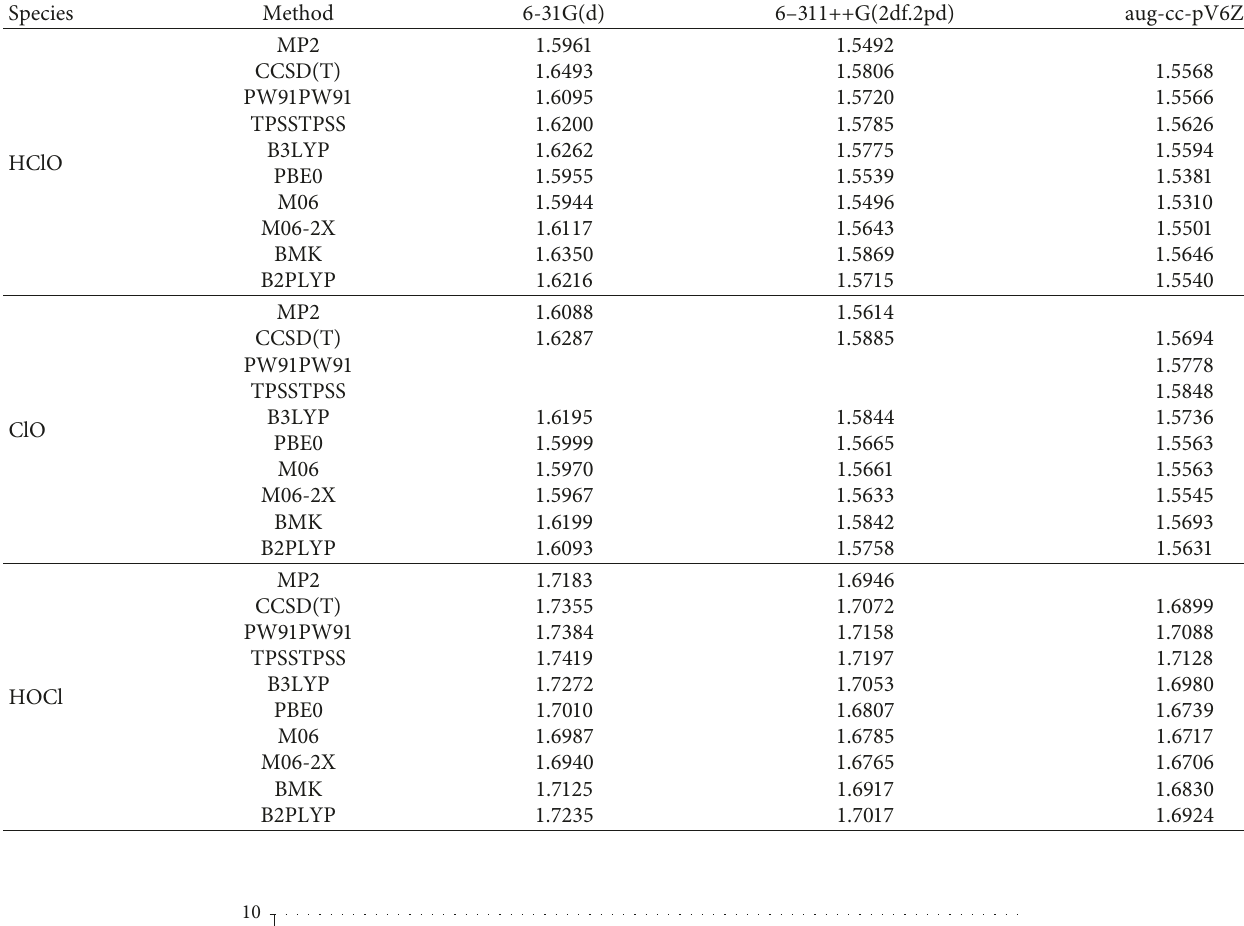
Table 4: Optimum ClO bond length (in A ) calculated at different theoretical levels for the three species HClO, ClO, and HOCl.